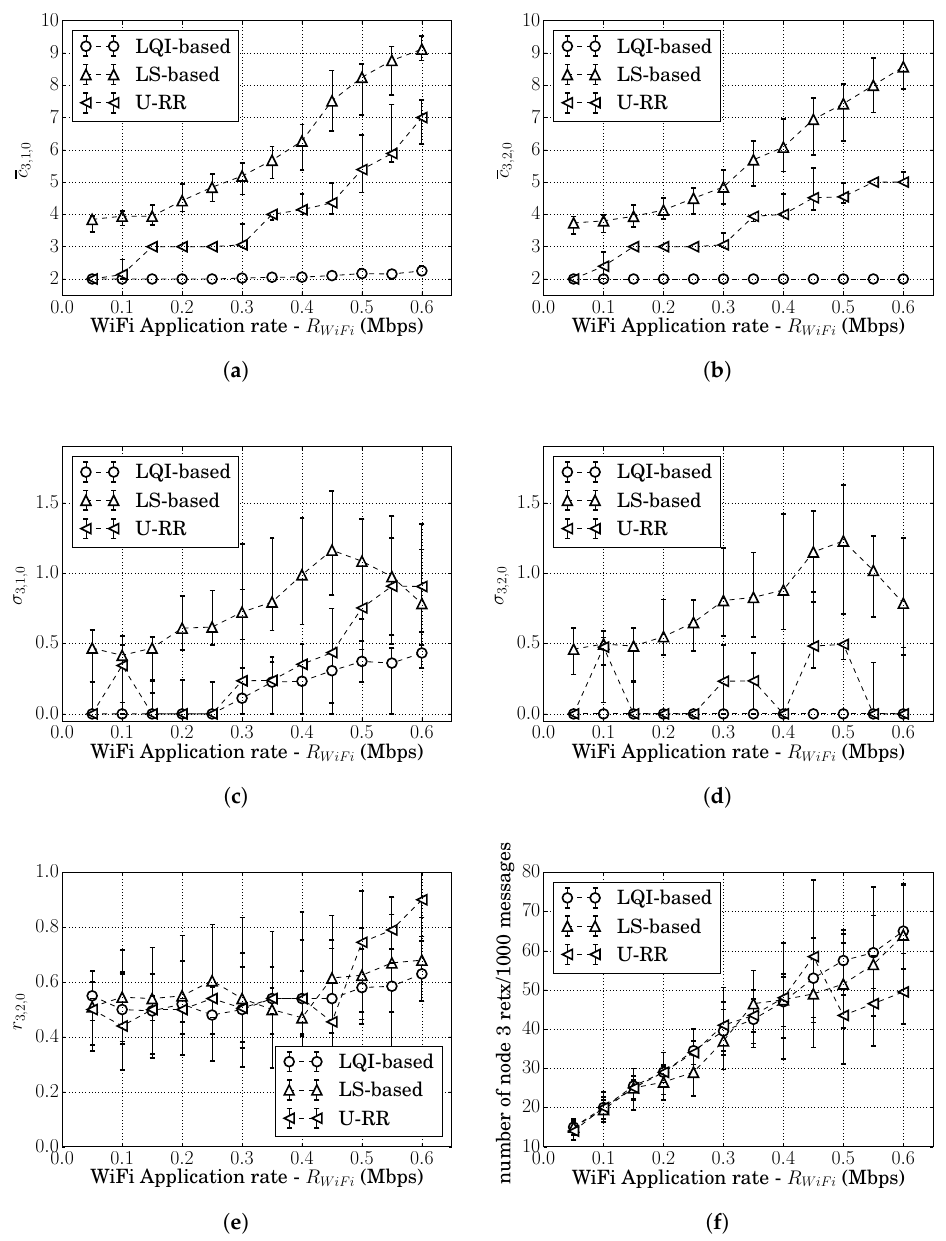
Figure 11. The median and the 15th to 85th percentiles of ( a ): the cumulative route costs of the route 3,1,0 ( c 3,1,0 ), ( b ): the cumulative route costs of the route 3,2,0 ( c 3,2,0 ), ( c ): the standard deviation of the estimated costs measured at node 3 for the route 3,1,0 ( σ 3,1,0 ), ( d ): the standard deviation of the estimated costs measured at node 3 for the route 3,2,0 ( σ 3,2,0 ), ( e ): the ratio of times that route 3,2,0 was chosen ( r 3,2,0 ), and ( f ): the number of times that node 3 had to retransmit per 1000 messages generated in the scenario